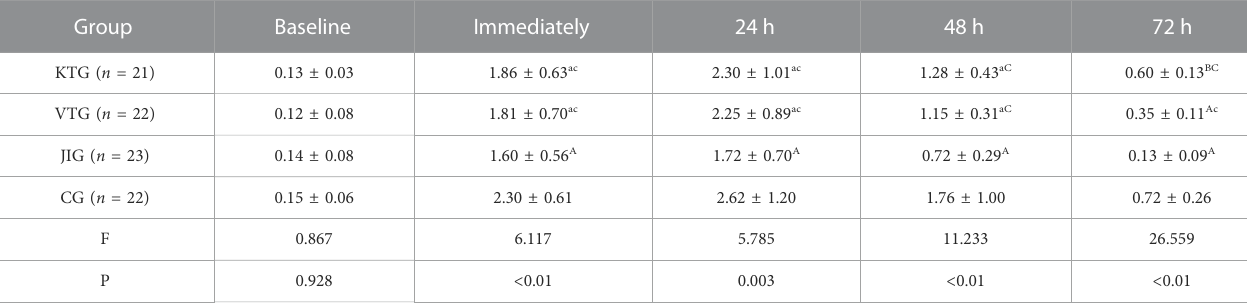
TABLE 2 VAS scores test for knee extension at different times.